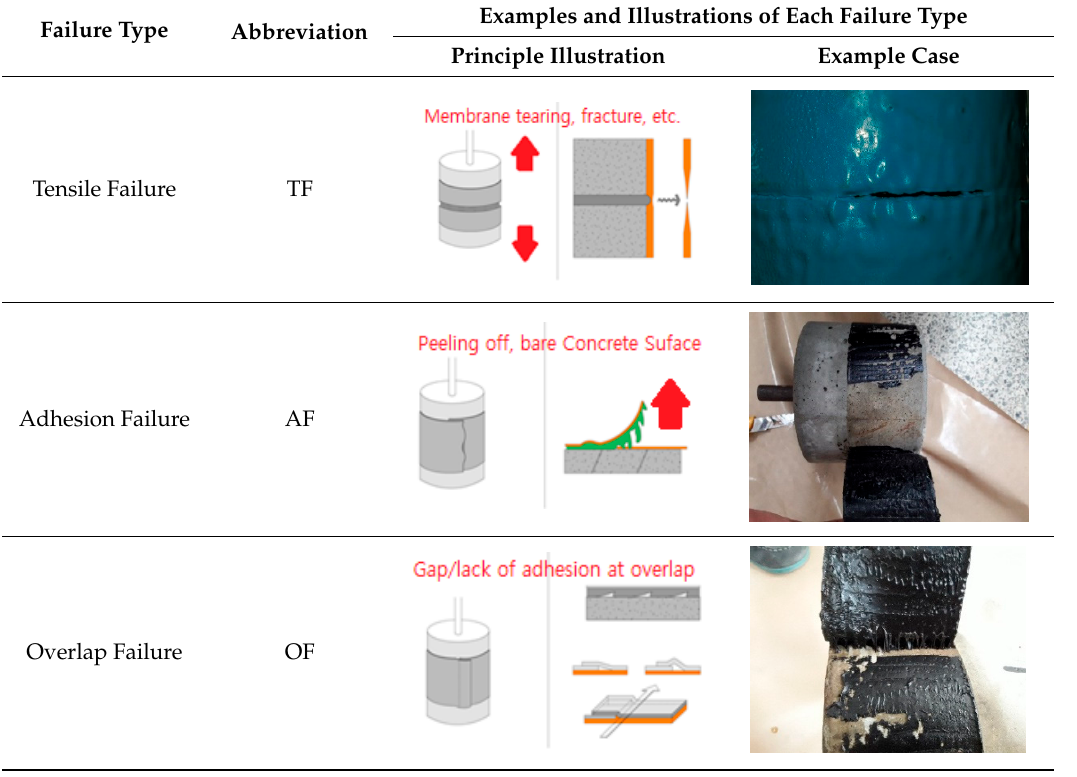
Table 8. Material property and workability evaluation based on failure types and causes.